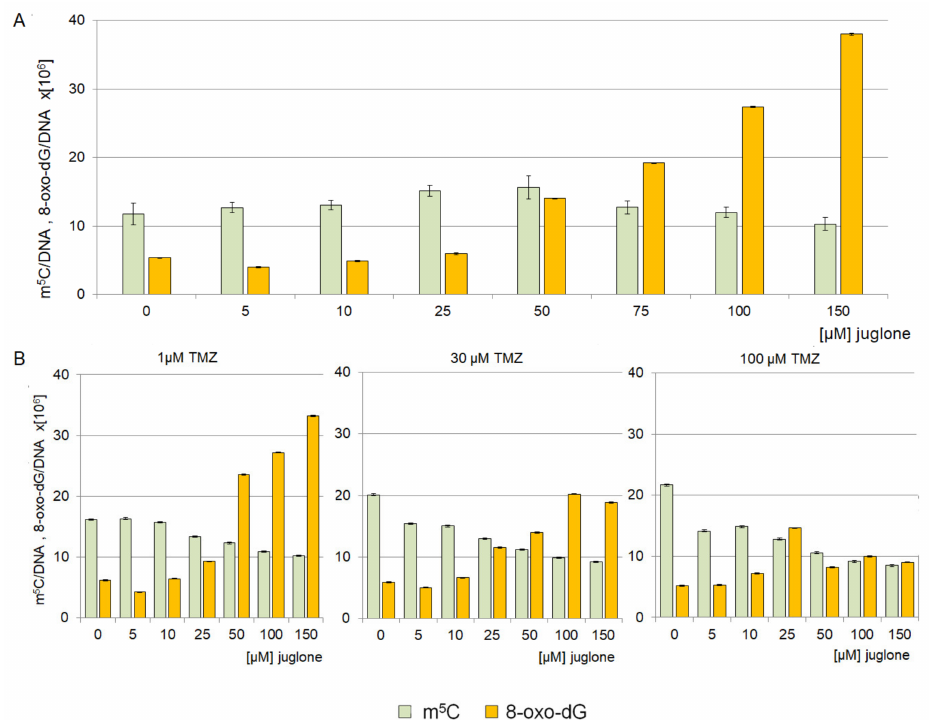
Figure 7. Contents of m 5 C and 8-oxo-dG in DNA from T98G cell line after treatment with juglone alone ( A ) and in combination with TMZ ( B ). The analysis was performed after 24 h of incuba- tion. Control experiment cells were treated with DMSO only. The R values are the means from four